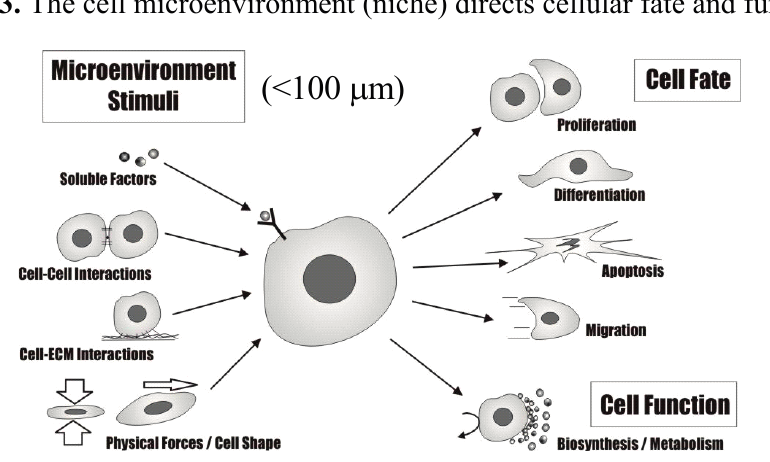
Figure 3. The cell microenvironment (niche) directs cellular fate and